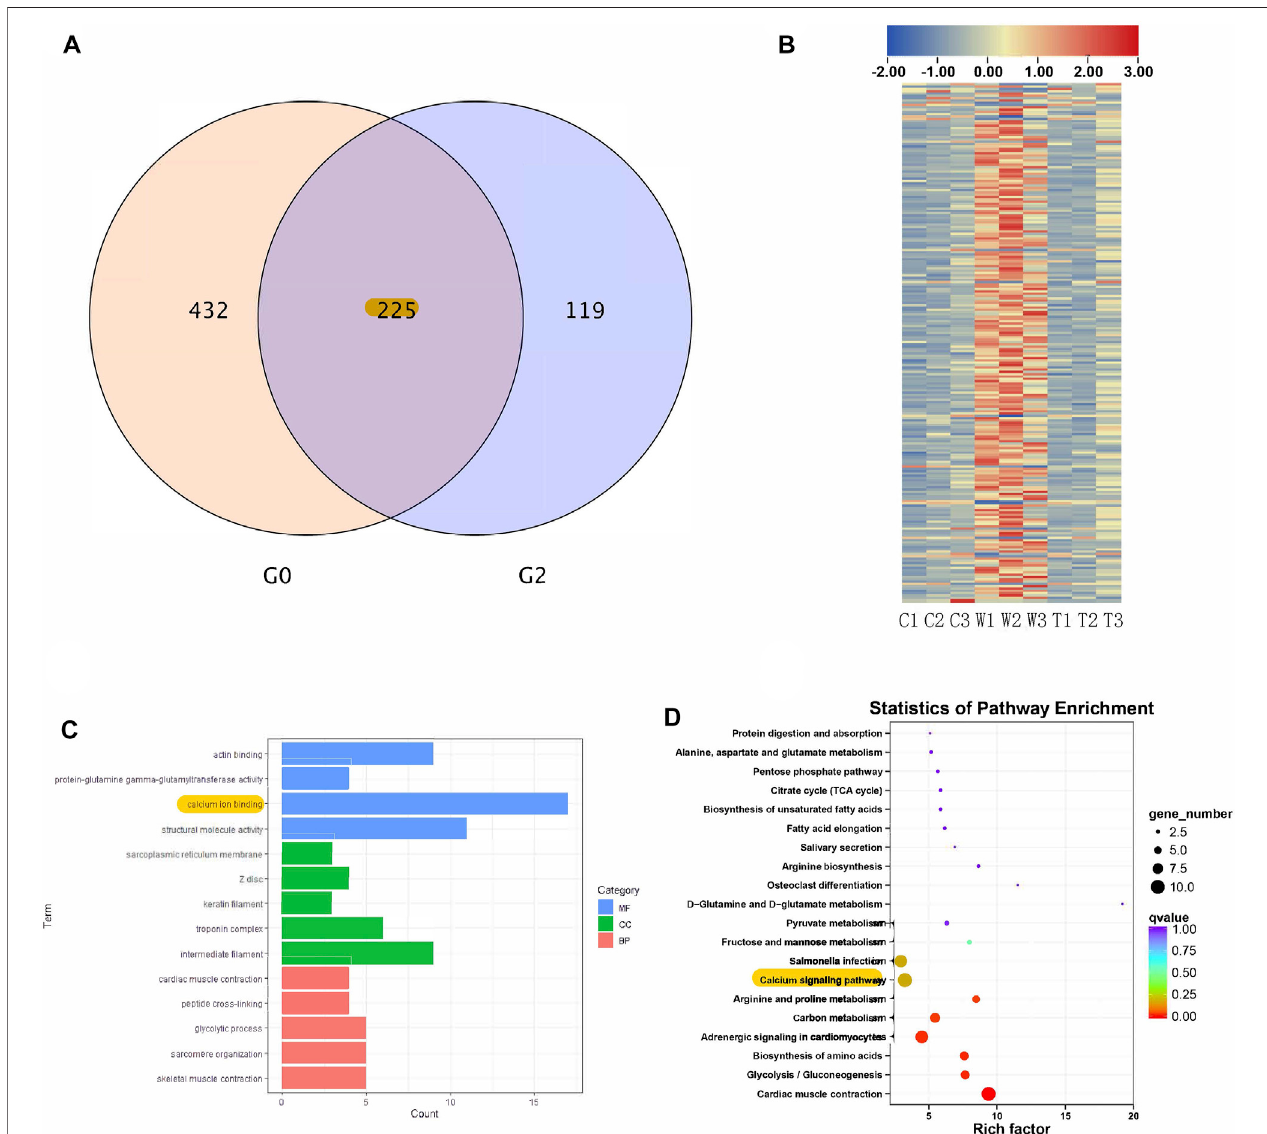
FIGURE 4 | RNA sequencing results; (A) Venn diagram of overlapped genes between control vs withdrawal (G0) and withdrawal vs withdrawal + TxIB (G2) datasets; (B) Heatmap of expression of overlapped 225 genes ( “ C ” indicates Control group, “ W ” indicates alcohol withdrawal group, “ T ” indicates withdrawal + TxIB group); (C) GeneOntologyenrichmentofoverlapped225genes.MF:molecularfunctionCC:cellularcomponentBP:biologicalprocess; (D) KEGGpathway enrichment of overlapped 225